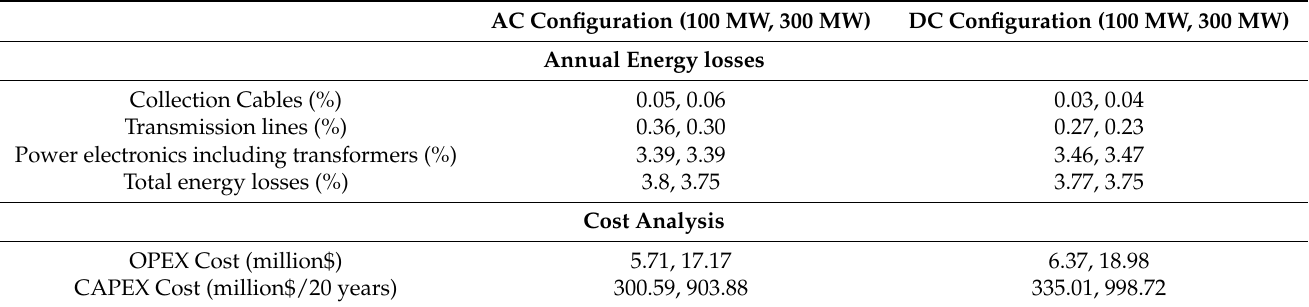
Table 4. Annual Energy losses and costs of components in the two offshore transmission modes